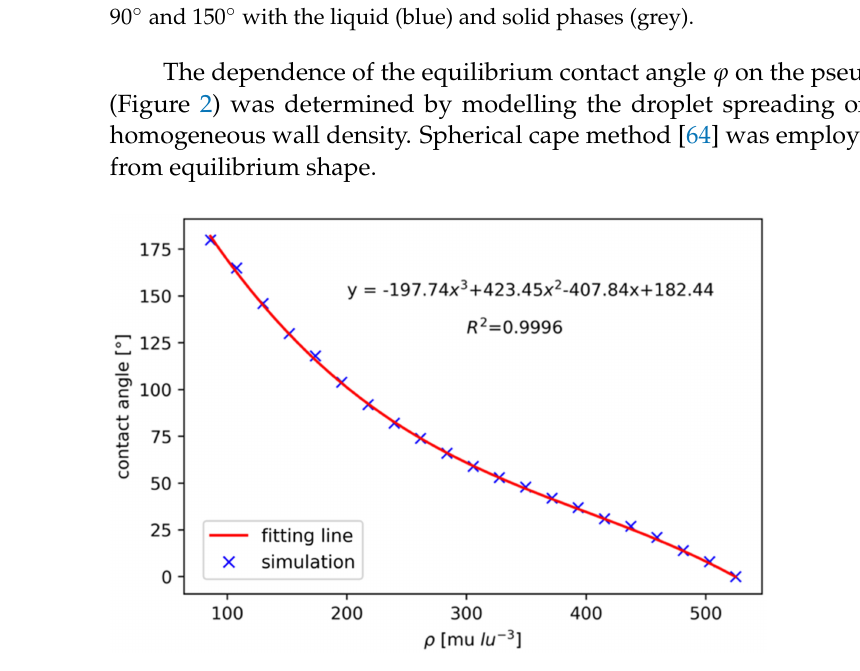
Figure 2. Dependency of equilibrium CA on pseudo wall density ρ wall with fitting line and